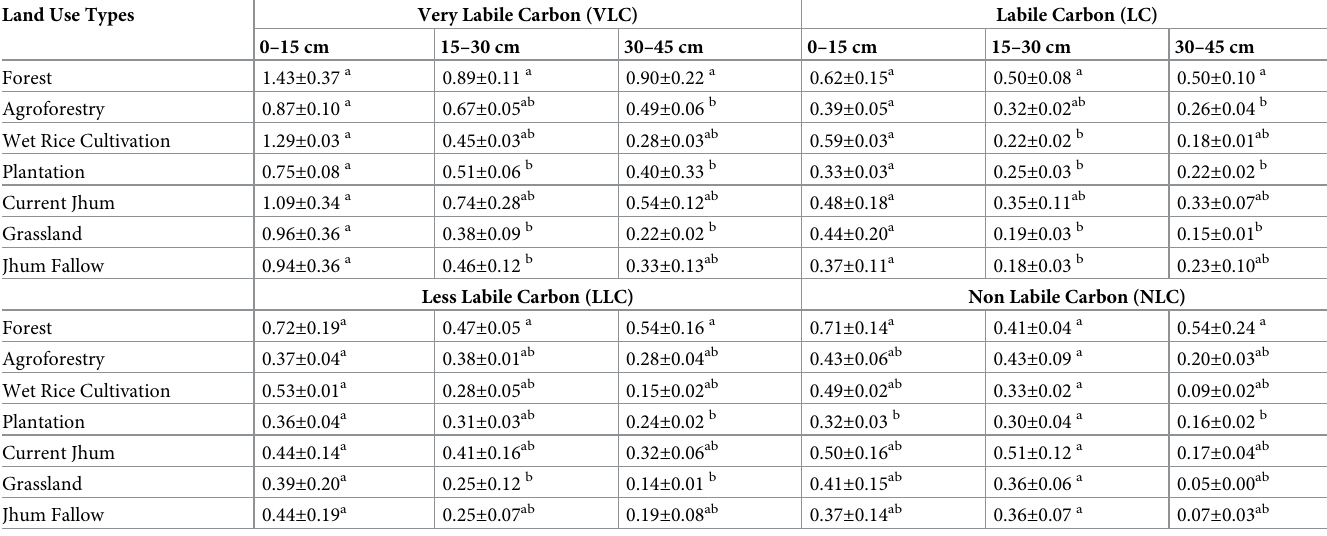
± indicates standard error of mean. Values in same column followed by different letters are significantly different (p <